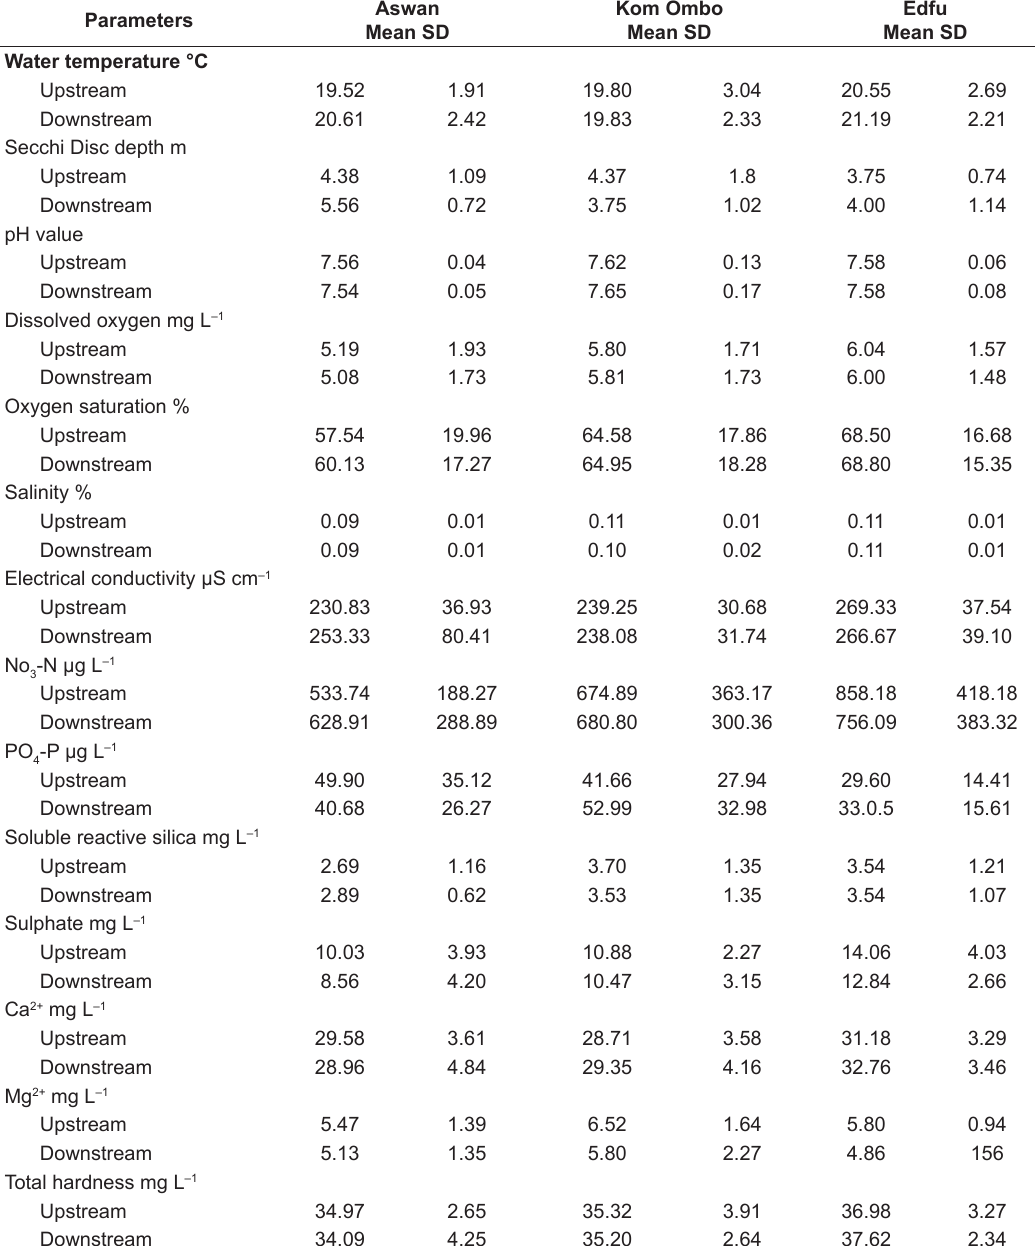
Table 1. Mean annual values and standard deviations (SD) of water quality parameters along the main stream of the Nile in Upper Egypt during